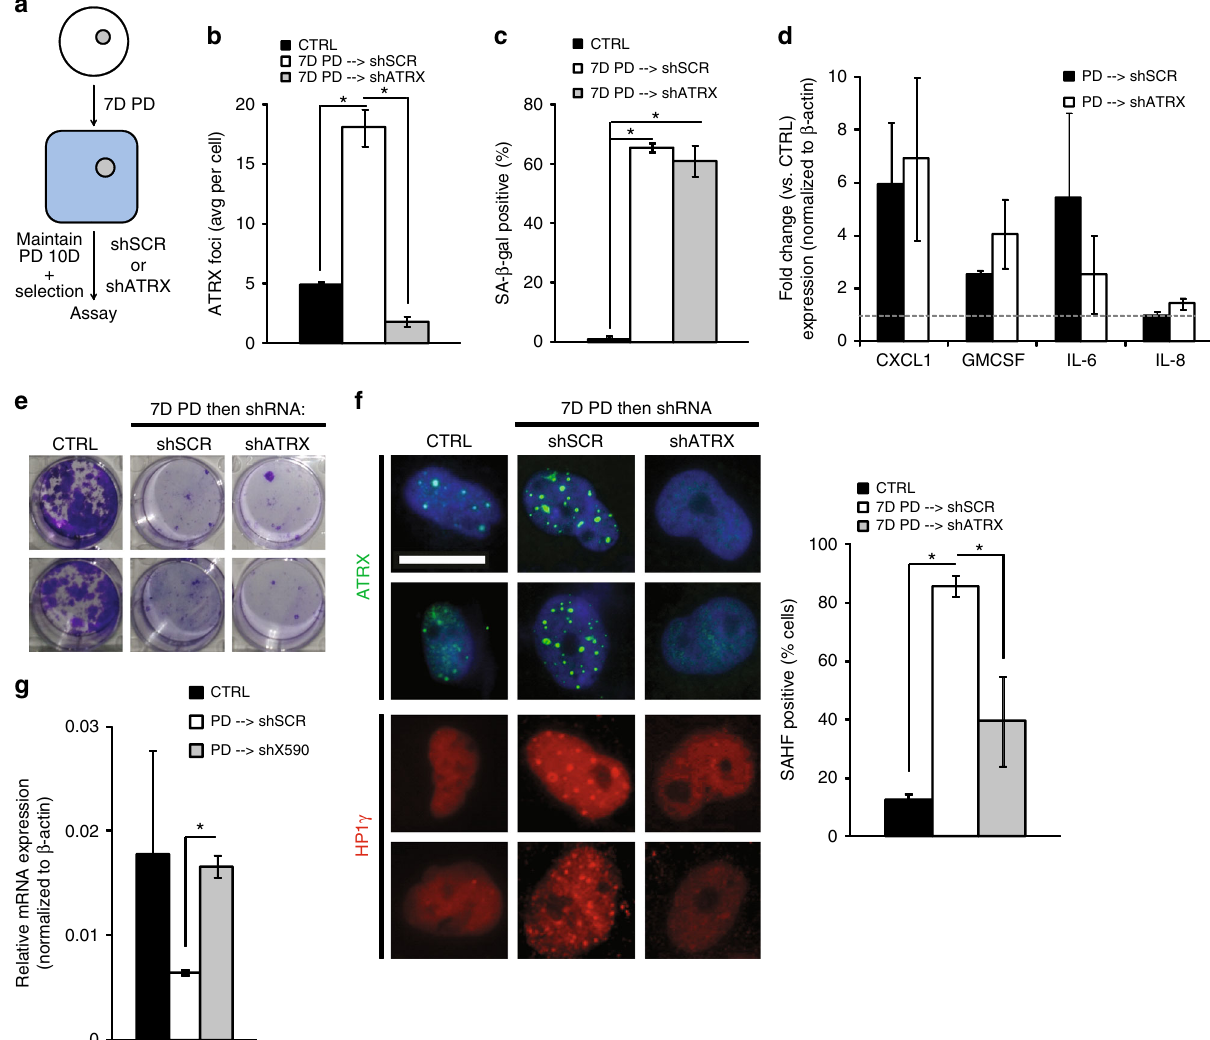
Fig. 4 ATRX is required for maintenance of HP1 γ SAHF in senescent cells. a LS8817 cells were treated as described. b – d Cells were then fi xed and the number of ATRX foci ( b ), the accumulation of SA- β -gal-positive cells ( c ), and the accumulation of four mRNAs of the SASP cytokine program ( d ) were measured. e Clonogenic growth was assessed after cells were replated at low density the absence of drug. Colony number is not quanti fi ed as individual colonies could not be discerned. f The accumulation of HP1 γ -positive cells (SAHF) was determined. Representative images are shown ( left ) and the percentage of SAHF-positive cells was quanti fi ed ( right ). g HRAS mRNA levels were analyzed by qPCR. All data are represented as mean ± SEM from at least three independent experiments. Asterisk indicates p < 0.05 using a two-sided Students t- test. All images were taken at the same magni fi cation. The scale bar is 20